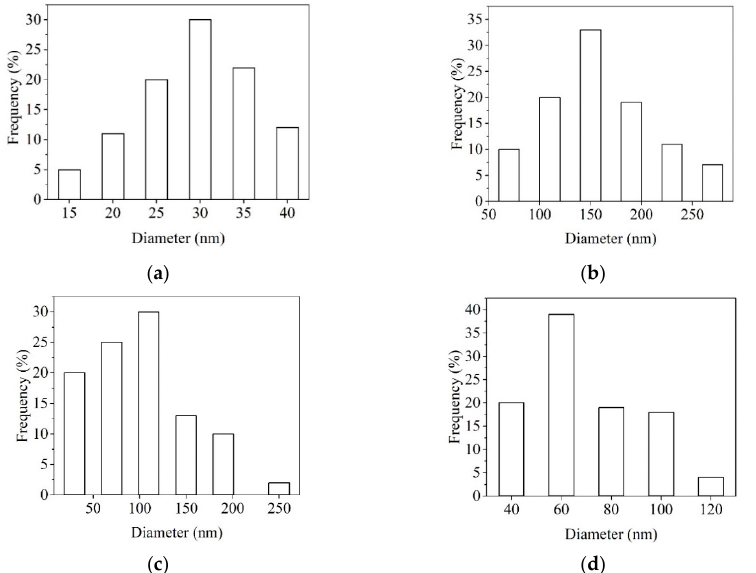
Figure 2. Dimension of collagen-based nanofibers. Col—collagen glue nanofibers ( a ) , Col/ZnO NPs ( b ) , Col/TiO 2 -N-AgNPs ( c ) , and Col/CS ( d ).